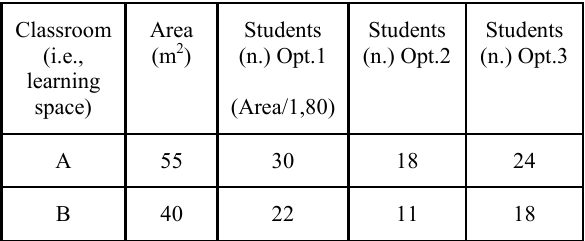
Table 1. Maximum number of students allowed to staying in CTS’s technical report